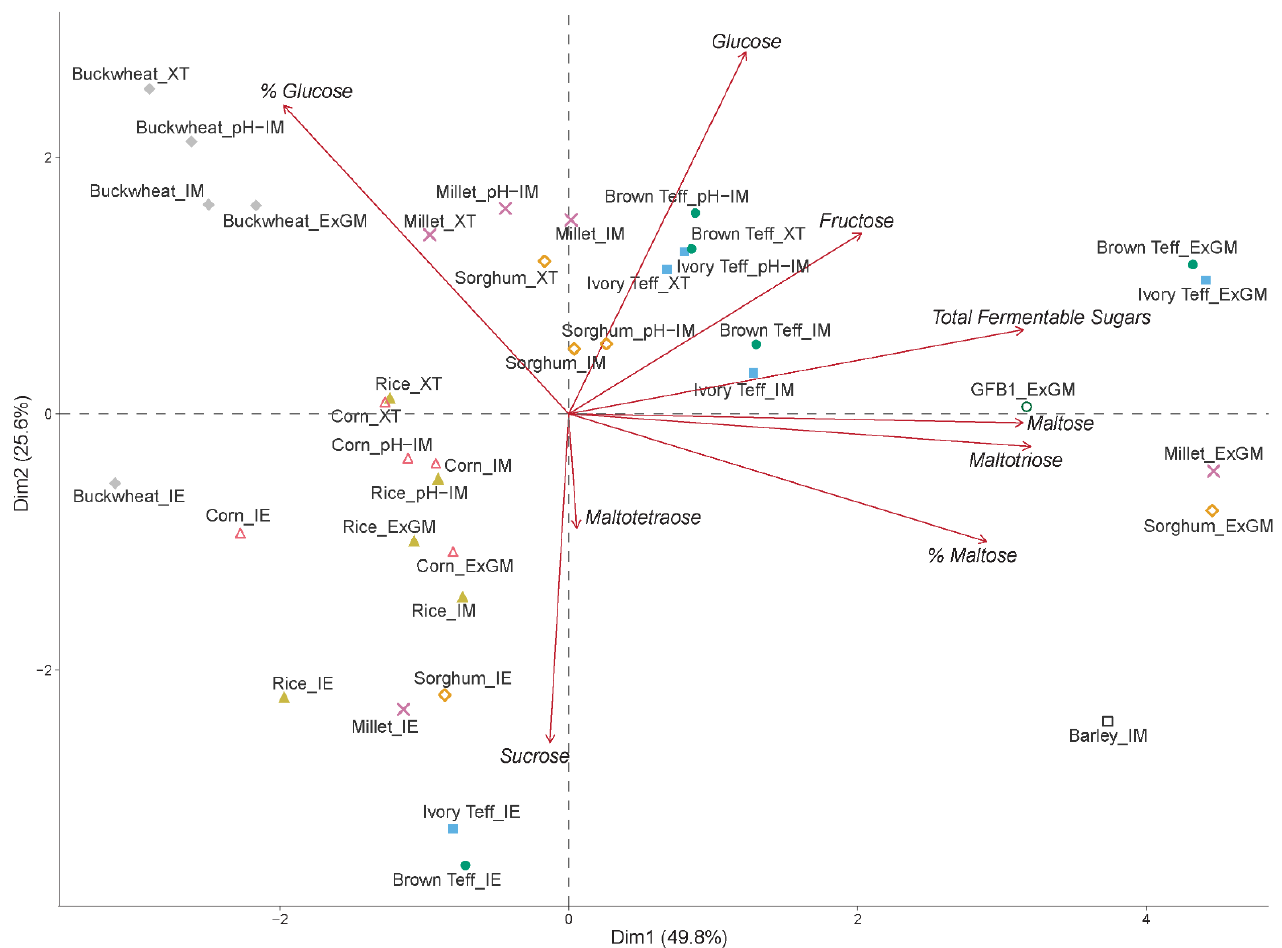
Figure 3. PCA biplot showing the sugar analysis results of the mashing experiments for each treatment for the first two dimensions. Individual mashes are labelled as Malt_Mashing Treatment. The variables as indicated by the vectors are the concentrations of the individual sugars measured, the sum of the fermentable sugars, with % glucose and % maltose corresponding to the percentage of glucose or maltose in the total fermentable sugar output of each wort. The mashing treatments outlined in Table 1 are: inactivated enzymes (IE), infusion mash (IM) pH-adjusted infusion mash (pH-IM), extended time infusion mash (XT), and the ExGM decoction (ExGM).